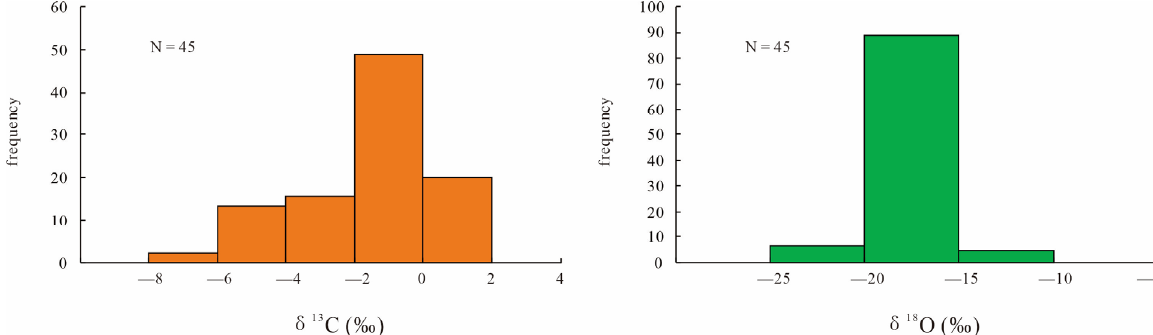
Figure 10. Distribution frequency histogram of carbon and oxygen isotopes results of calcite cements.